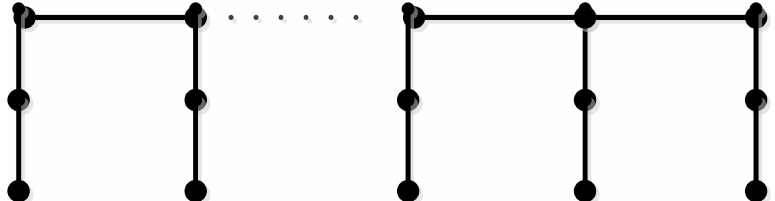
Fig. 5 The nano structures bridge graph G d ( P n , v 1